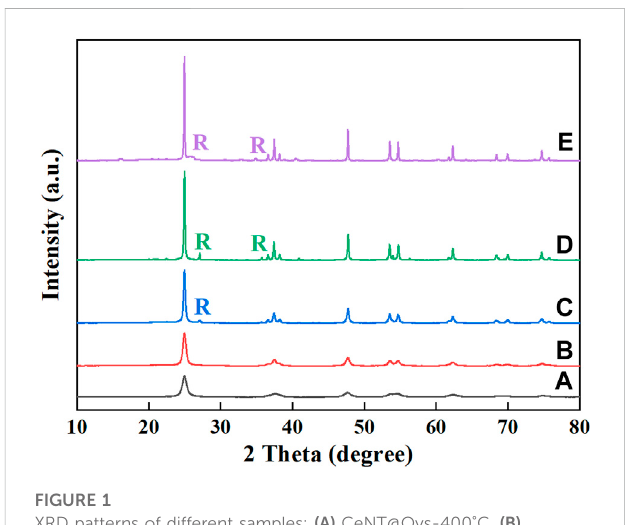
FIGURE 1 XRD patterns of different samples: (A) CeNT@Oys-400 ° C, (B) CeNT@Oys-500 ° C, (C) CeNT@Oys-600 ° C, (D) CeNT@Oys-700 ° C, (E) TiO 2 -500 °